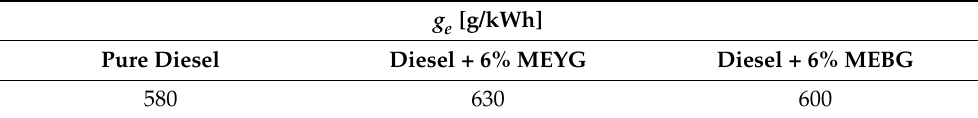
Table 1. The fuel consumption g e at zero engine load.